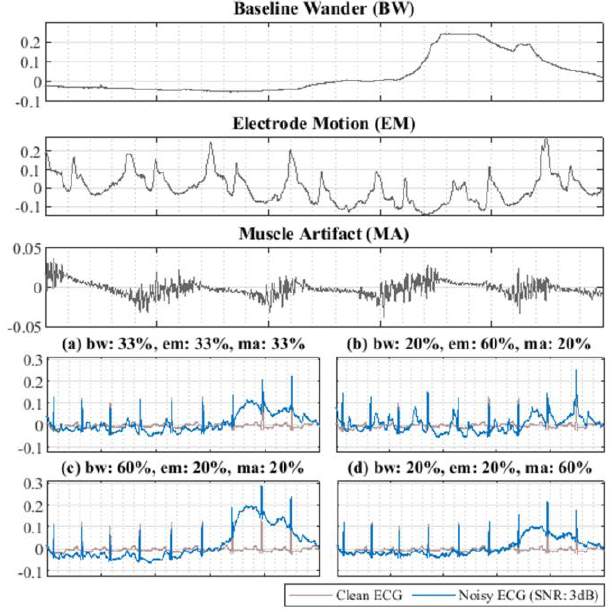
Figure 1. Noisy ECG signal mixed with different component ratios of BW, EM, and MA. ( a – d ) illustrate the noisy ECG with 3 dB SNR and clean ECG signal, BW, EM, and MA artifacts in the same segment.